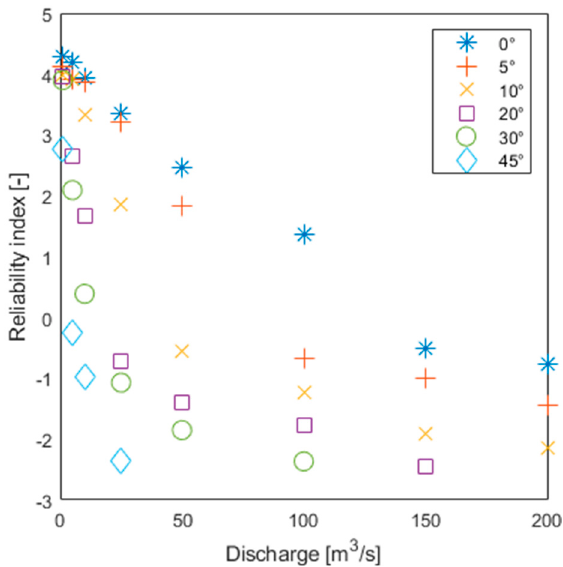
Figure 7. Reliability index of the case study for each discharge value (Q1–Q8) considering different flow angles of attack.